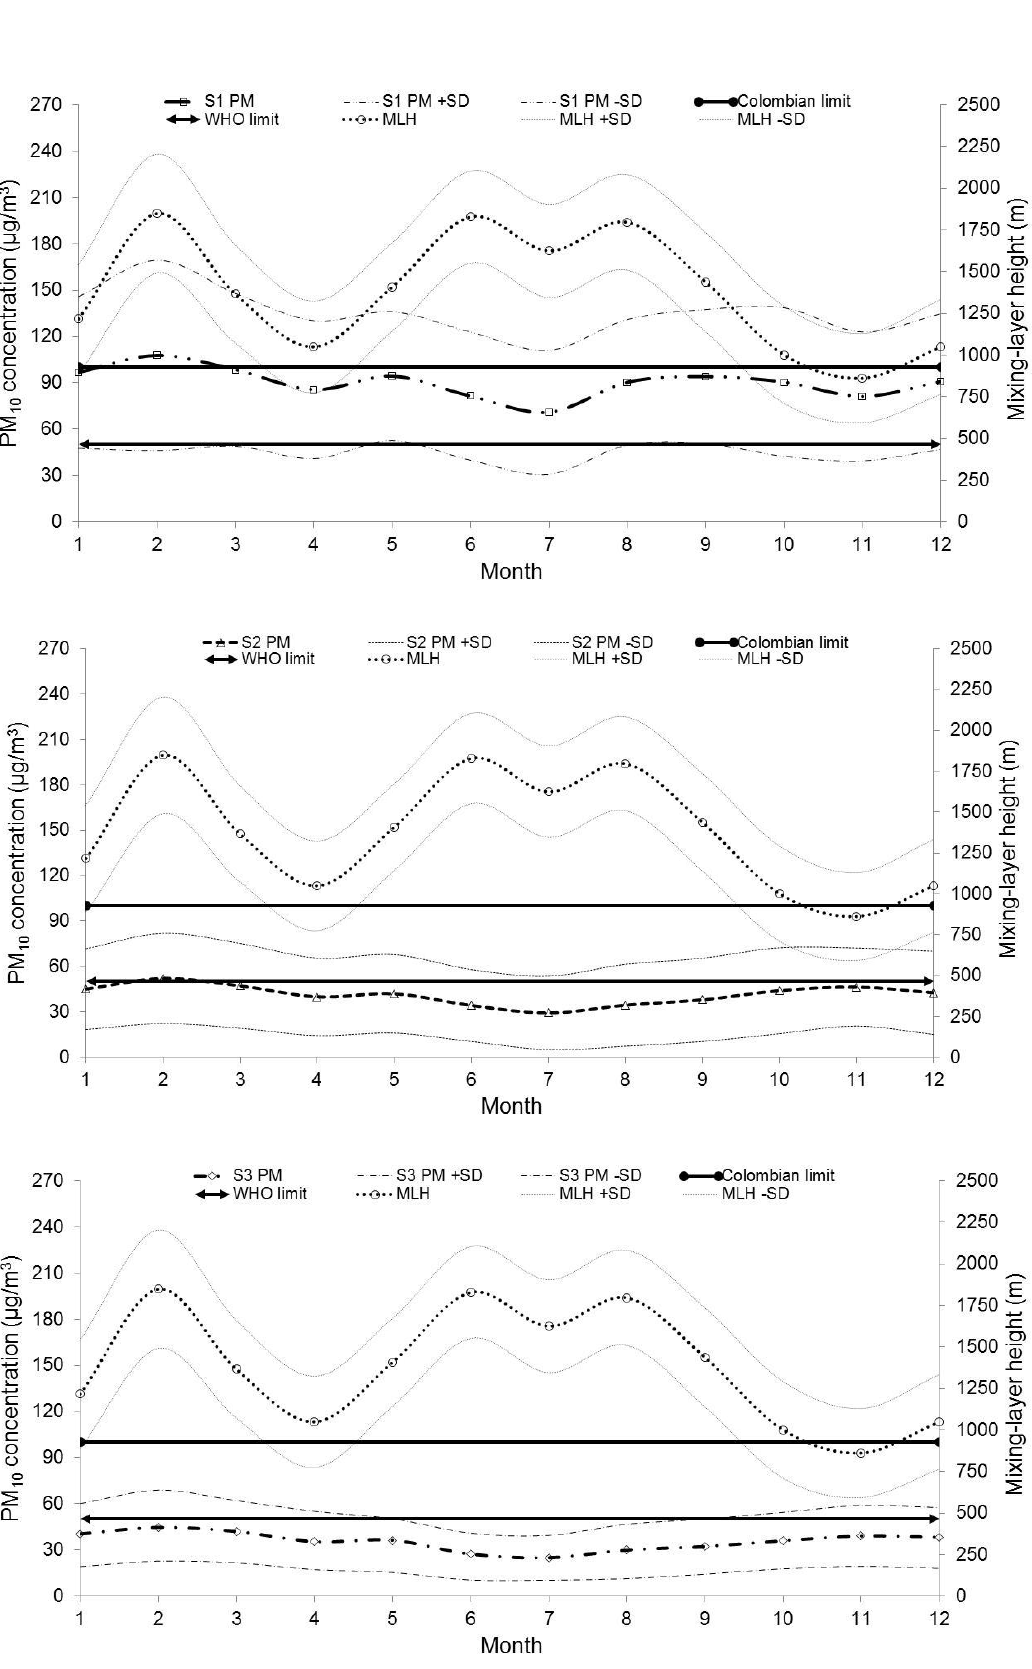
Figure 3. Average DPM 10 and MLH in monitoring stations (S1, S2, and S3). Month: 1 = January, 2 = February, 3 = March, 4 = April, 5 = May, 6 = June, 7 = July, 8 = August, 9 = September, 10 = October, 11 = November, and 12 = December. PM = PM 10 concentration. MLH = mixing-layer height. SD = standard deviation.